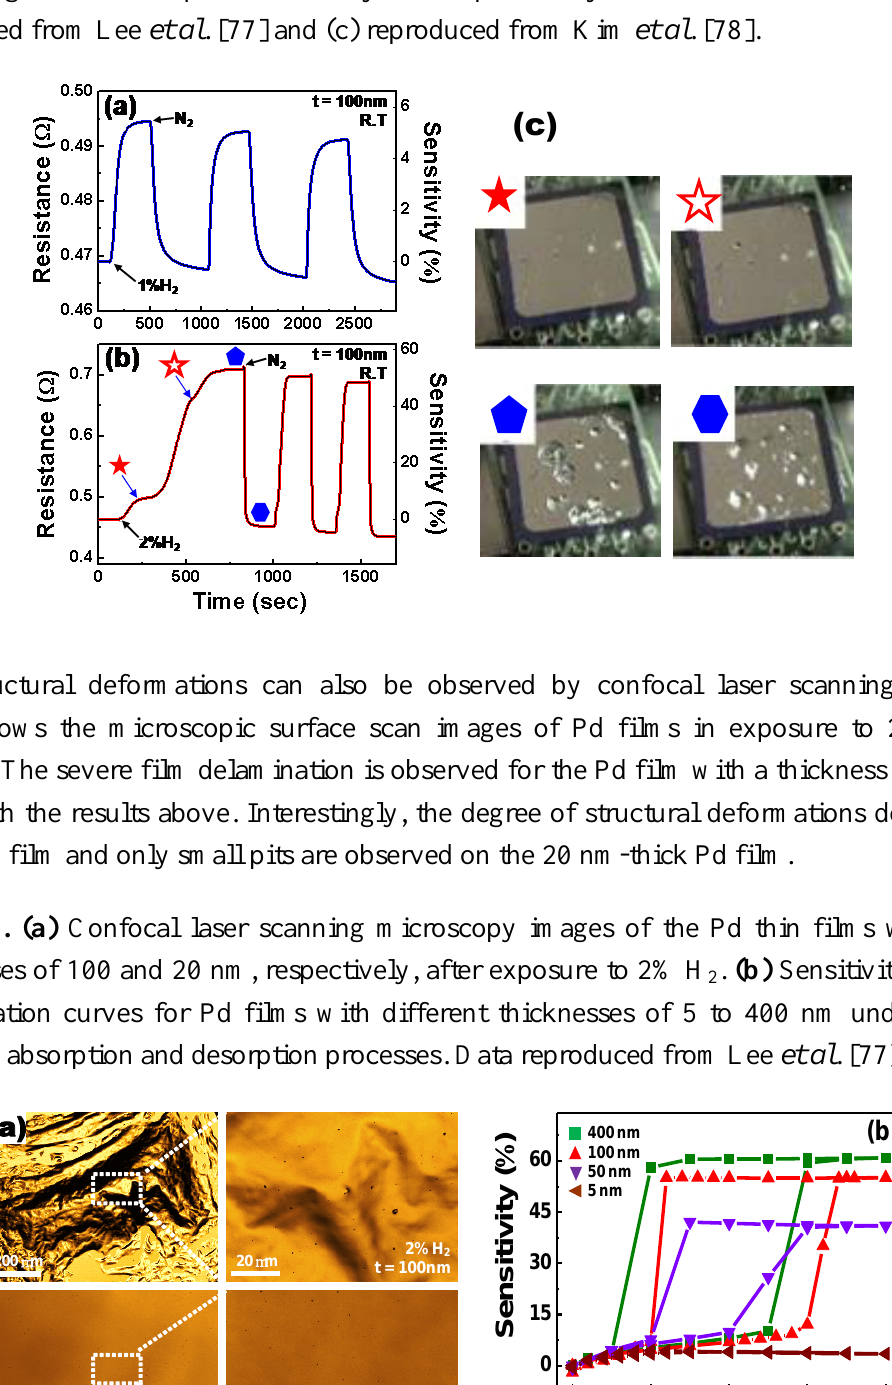
Figure 2. Electrical resistances and the corresponding sensitivities of a 100 nm-thick Pd thin film in response to (a) 1% H and (b) 2% H at room temperature. (c) Film 2 2 morphologies at the steps indicated by the respective symbols in (b). (a) and (b) Data reproduced from Lee et al . [77] and (c) reproduced from Kim et al . [78].